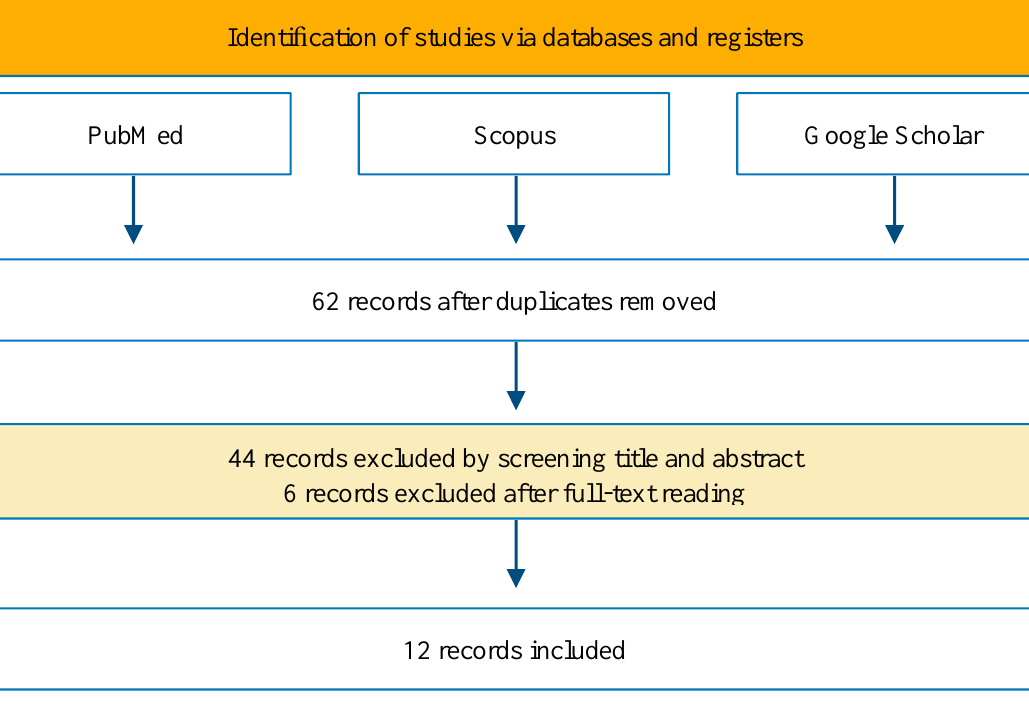
Figure 3. Flow diagram of the review.